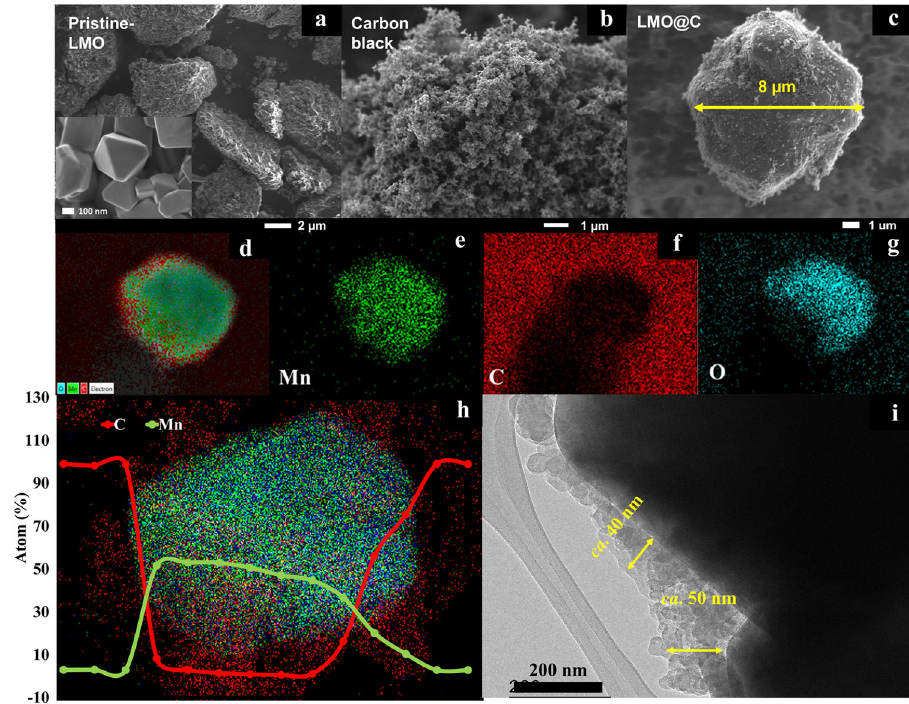
Fig. 1 Morphology of pristine-LMO and LMO@C materials. SEM images of ( a ) pristine-LMO, ( b ) carbon black, and ( c ) LMO@C. d – g SEM-EDS of LMO@C. h STEM-EDS line scanning of LMO@C. i HR-TEM images of